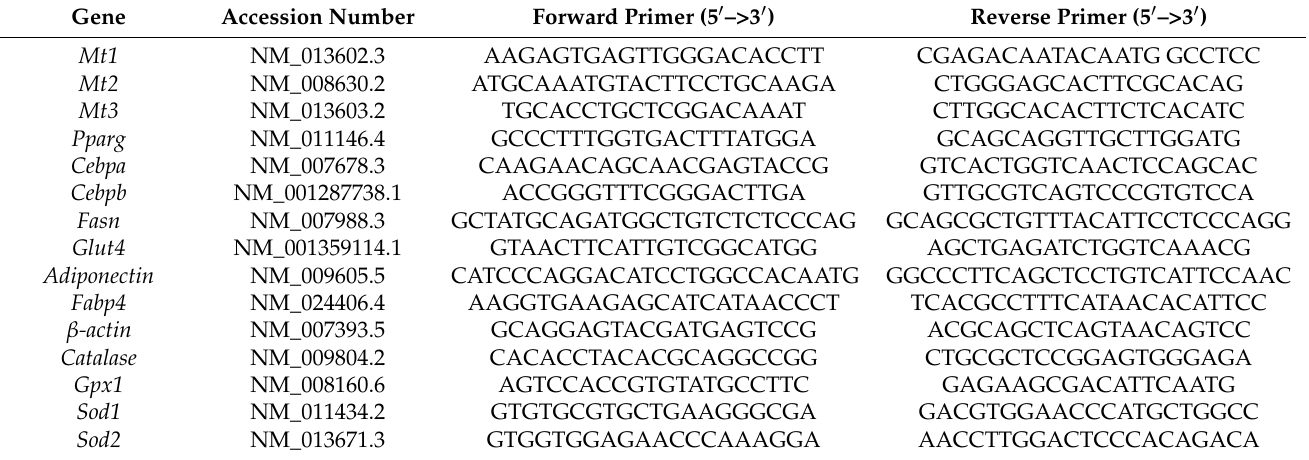
Table 2. Primer sequences used for